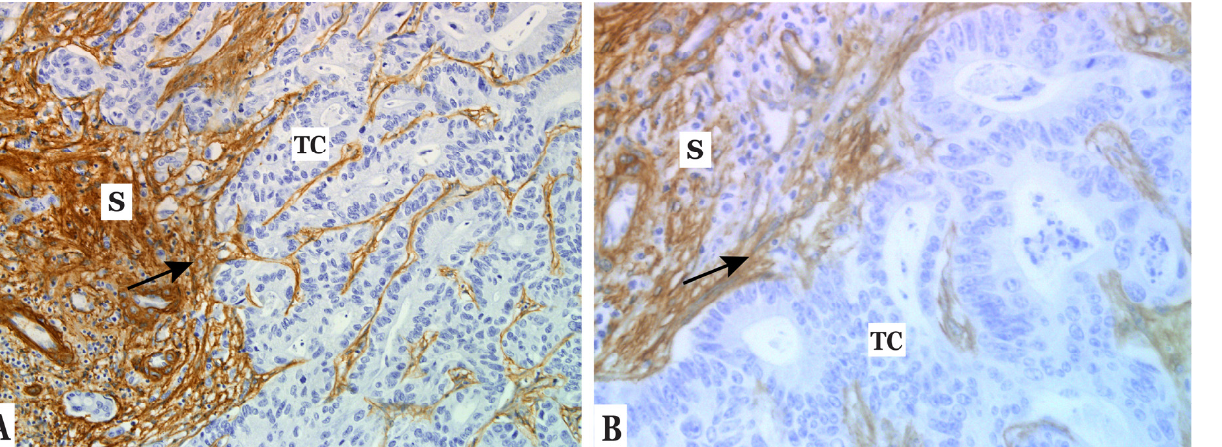
Figure 2. Type IV collagen (COL IV) is expressed by CAFs in colorectal liver metastases (CLM). ( A – C ) The RNA expression of COL IV was analyzed with in situ hybridization (ISH) and COL IV (pink) was expressed by fibroblasts (arrow) in the stroma (S) of CLM. ( C – E ) To validate COL IV expression by fibroblasts, consecutive tissue sections were immunohistochemically stained for CAF markers ( D ) α -SMA and ( E ) FAP. The expression (brown) of α -SMA and FAP in the stroma (arrow) of CLM was compared with the ( C ) RNA expression of COL IV (pink). ( A , B ) Magnification ×40 and ( C – E ) ×20. Extra unspecified magnification to visualize COL IV RNA-positivity. Abbreviations: TC = tu- mor cells, S = stroma. 3.3. Type IV Collagen Is Produced by Fibroblasts In Vitro but Not by Colorectal Cancer Cells The expression of COL IV in vitro was assessed by IF analysis of three CRC cell lines and three fibroblast cell lines. The results showed that COL IV is only produced in vitro by fibroblasts derived from the colon. COL IV was clearly expressed by CCD-18Co and CCD112-CoN (see Figure S1). CCD-18Co was positive for COL IV for all experiments, whereas CCD112-CoN was positive in two of three experiments. WS1 was negative for COL IV in all experiments and all CRC cell lines were negative (see Figure S1).